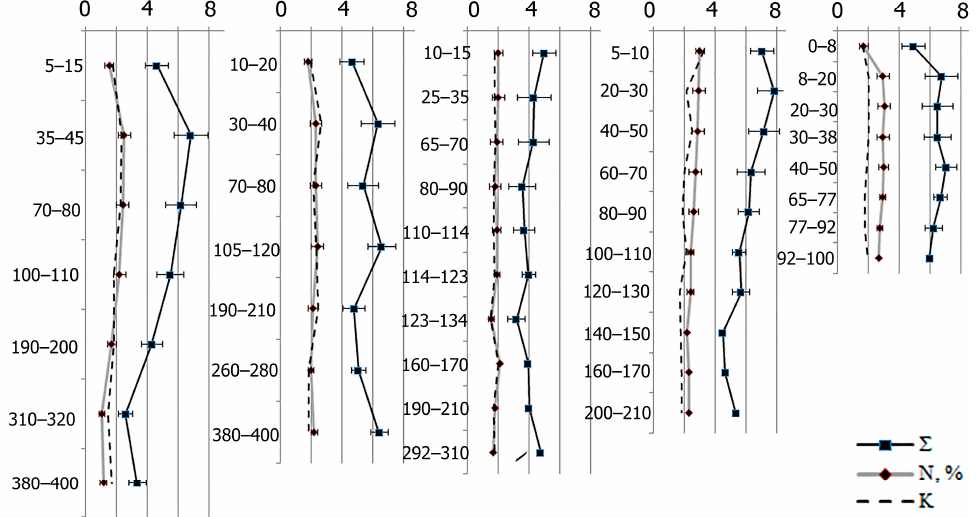
Figure 2. Profile change in terms of the sum of amino acids ( Σ ), the mass fraction of nitrogen in dry matter (N, %), and the mole fraction ratio of hydroxy AAs to heterocyclic AAs (K). A rather significant spread in the values concerning AA concentration is explained by the differences in the plant macrofossil composition of peat strata. Indeed, in the above- ground part of the shrub and herbaceous vegetation, a more significant nitrogen accumulation occurs in contrast to mosses and lichens. Second, the low reserve of AA fragments in the peatlands is defined by cyclical biological characteristics in the soil–plant system. Nutrients entering the soil are intercepted by living roots during the slow decomposition of dwarf shrub remnants and moss–lichen litter [30]. The variability of physicochemical properties and AA concentrations in peat indicate that there were differences in the paleogeographic conditions of the peatland during its genesis, as well as differences in terms of its ground water nutrition; thus, the lowland peat plateau (site Inta 1), during its initial stages, was mainly vegetated by eutrophic herbaceous–hypnum communities with a predominance of hygrophilic species, which were replaced by mesotrophic shrubs, and later replaced again by hygrophilic eutrophic plants. In foothill peat plateaus (sites Inta 11 and Voda-Ty), mesoeutrophic herbaceous communities